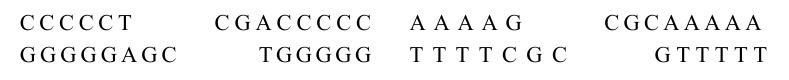
6 of 15 Figure 3. An example of FM. (3) Pseudo-bacteria mutation Pseudobac(R) . It takes an individual as a parameter and returns a new individual as follows. First, a random subsequence of nucleotides is identified as a gene. Then, a given number of candidate individuals are created by randomly changing one nucleotide in the selected gene. Finally, the candidate individual with the highest fitness value is returned. For example, in Figure 4, gene1 is randomly selected, and five variations are created by changing one nucleotide at a time (indicated by the shaded bold letter). One candidate individual is created by using each of the variants to replace gene1. Figure 4. Pseudo bacteria genetic operation diagram. This operator mimics a type of bacterial infection which, in a biological sense, may result in a new individual with an improved quality. The design is inspired by the pseudo-bacteria algorithm proposed by Yoshikawa et al. [27]. 3.3. Recombination Operation The recombination operator Recomb(R 1 , R 2 ) performs two sub-tasks: cutting the molecules by restriction enzymes and pasting together the molecules obtained, provided that they have matching sticky ends. It is designed based on the splicing model described by Amos and Paun [28]. This operation is performed according to another pre-specified probability r P . For each individual, a double-strand DNA is created from its single-strand DNA according to the complementary property of the nucleotides (i.e., A and T, and C and G are complementary to each other). For example, suppose R 1 = CCCCCTCGACCCCC and R 2 = AAAAGCGCAAAA, the following double-stranded DNA molecules will be